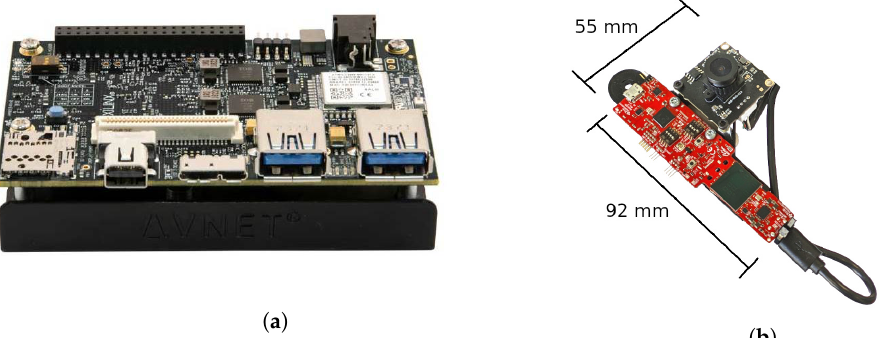
Figure 4. ( a ) The Ultra96-V2 onboard computer [31]; ( b ) sensor package with IWR6843AOPEVM mmWave radar sensor in red and AR0144 USB camera in